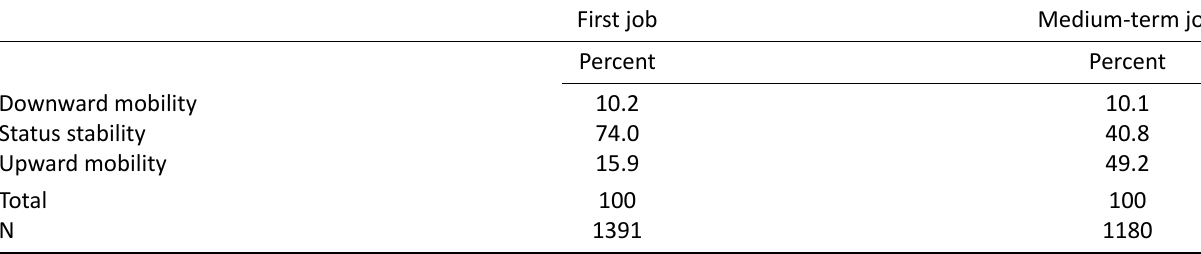
Table 1. Status mobility between training occupation and first and medium‐term job.